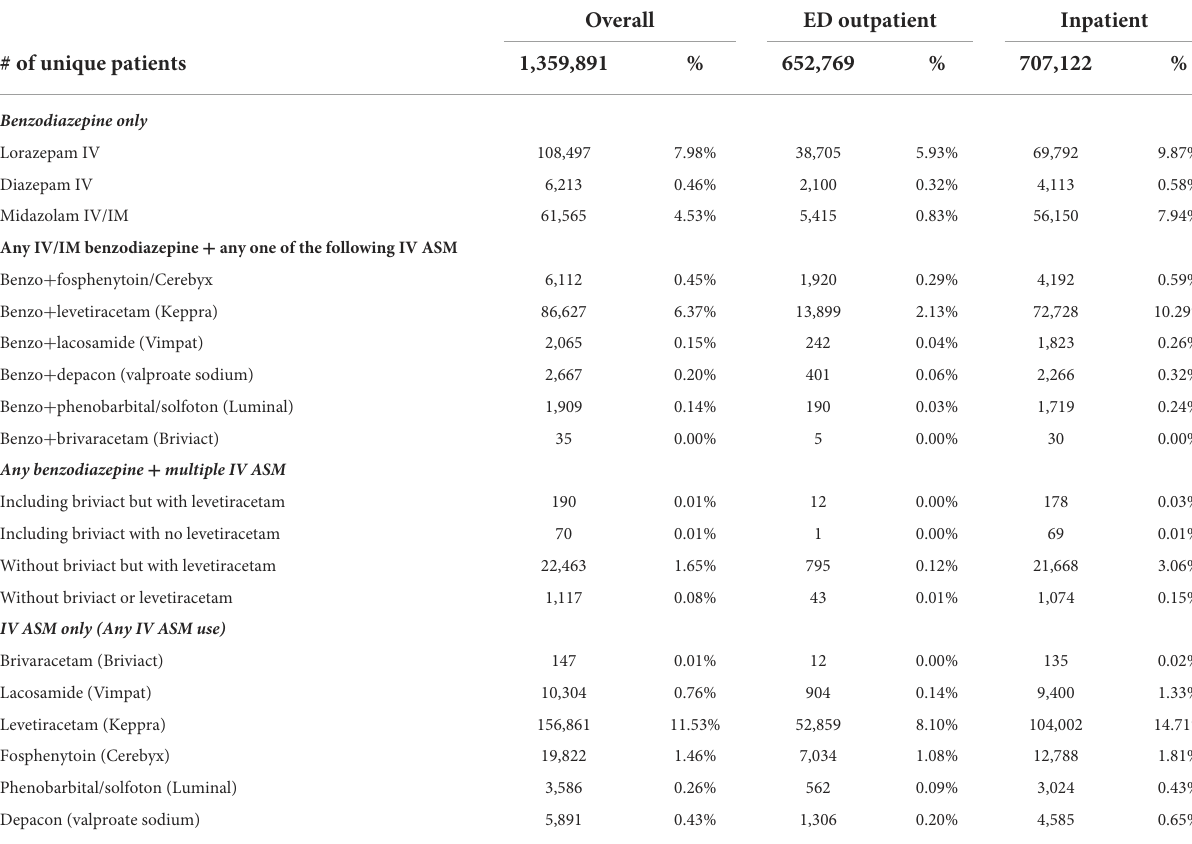
TABLE 3 Frequency distribution of seizure treatment regimens of interest by type of visit with seizure diagnosis. Overall ED